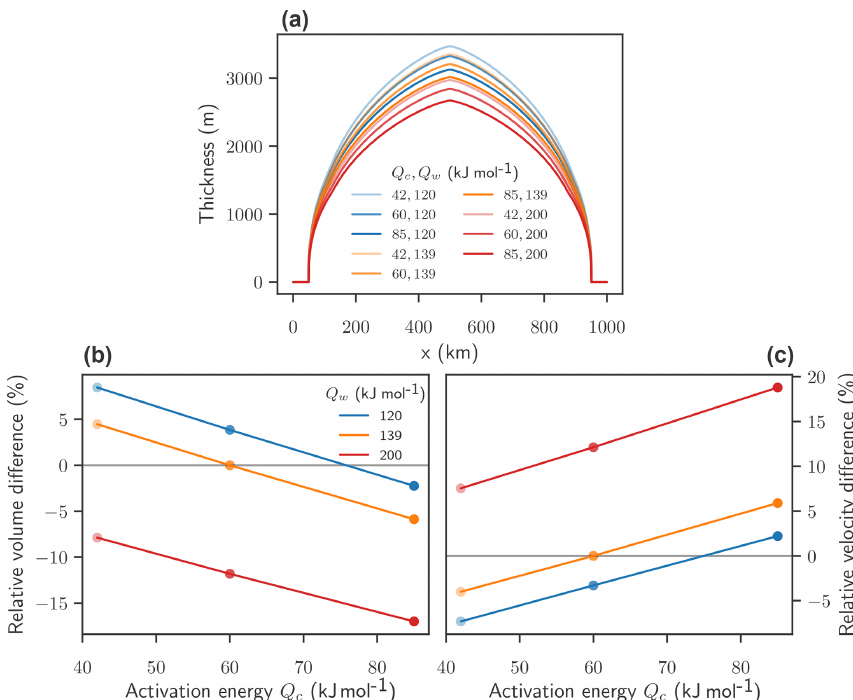
Figure 2. Effect of activation energies on equilibrium volume and velocities with fixed accumulation rate a = 0 . 5myr − 1 and flow exponent n = 3. Thickness profiles of equilibrium states for different combinations of activation energies Q w and Q c (a) . Relative difference of average equilibrium volumes (b) and velocities (c) compared to the reference state with standard parameters for parameter combinations of Q w and Q c . Q c is shown on the x axis, and Q w is given through the color of the markers (blue: Q w = 120kJmol − 1 ; orange: Q w = 139kJmol − 1 ; red: Q w = 200kJmol − 1 ).